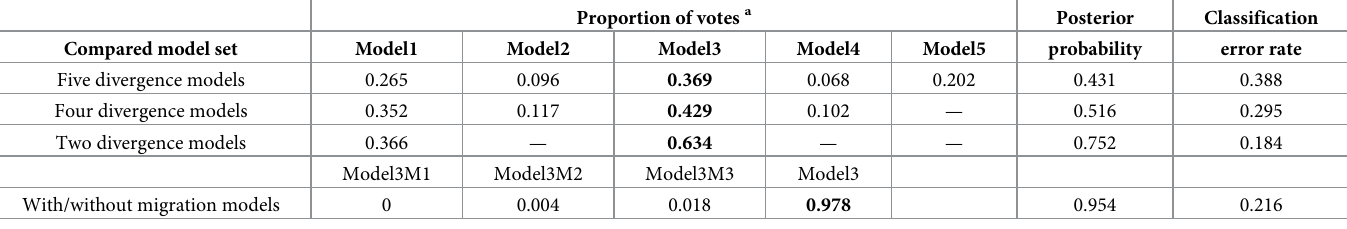
Table 2. Proportion of votes by random forest, posterior probability of the best model, and classification error rate in population divergence and migration